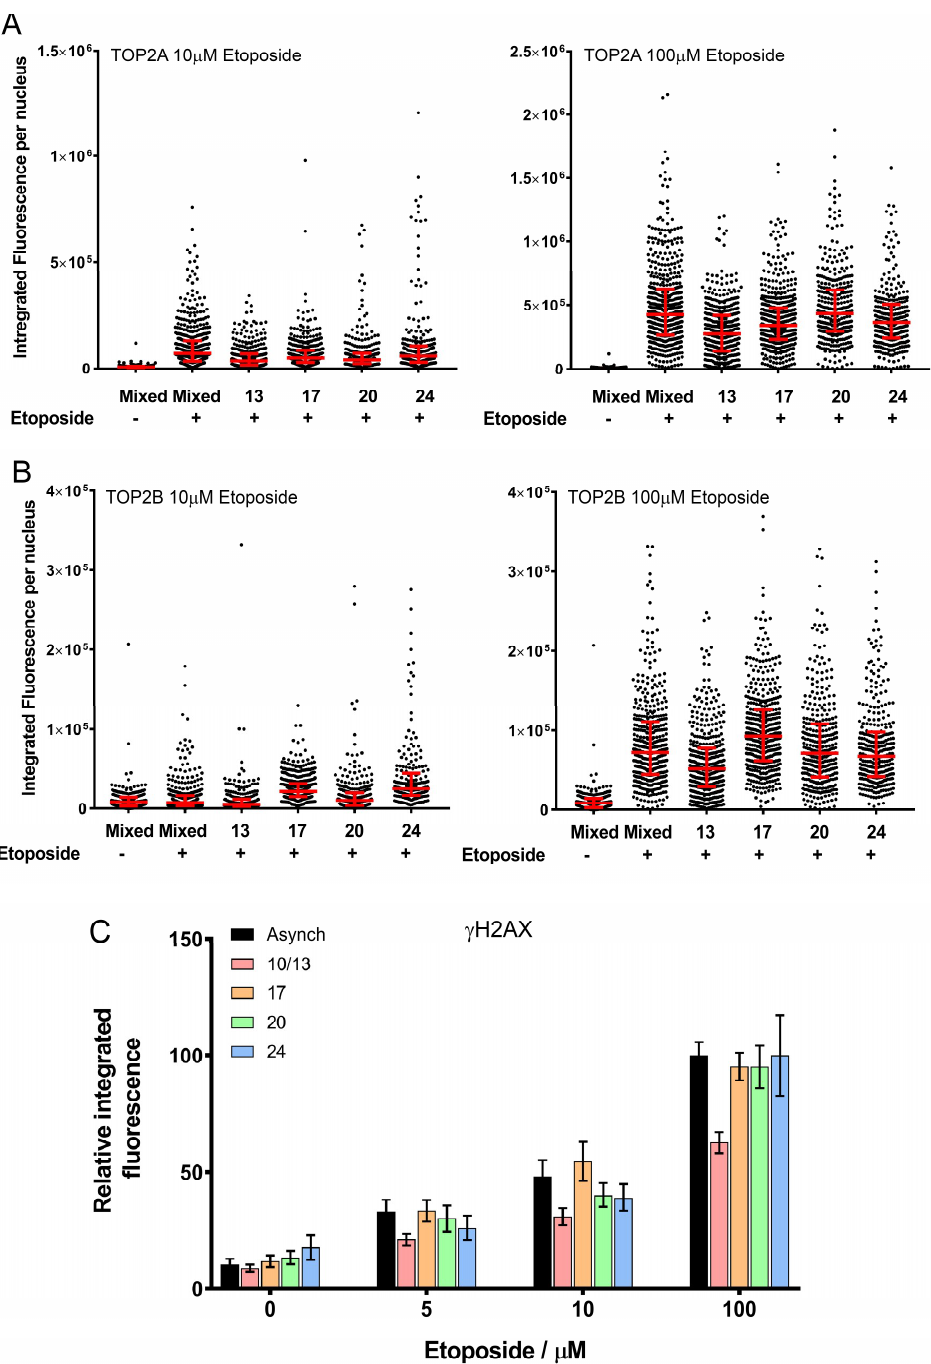
Figure 3. TOP2 covalent complex levels determined by trapped in agarose DNA immunostaining (TARDIS) and γ H2AX integrated fluorescence. Quantification of etoposide-induced TOP2A and TOP2B covalent-DNA complexes, ( A , B , respectively). Cells from each elutriated fraction were treated with etoposide (10 or 100 µ M) and TOP2-DNA covalent complexes were detected and quantified by TARDIS analysis [73–75,77]. The data are shown as scattergrams, derived from a single representative experiment. Bars represent the median and interquartile range. ( C ) Cells from each elutriated fraction were treated with etoposide (5, 10 or 100 µ M) or solvent (DMSO) and analysed by γ H2AX immunofluorescence; the level of γ H2AX integrated fluorescence was determined by quantitative immunofluorescence [77]. The data are shown as means of the medians obtained from three replicate